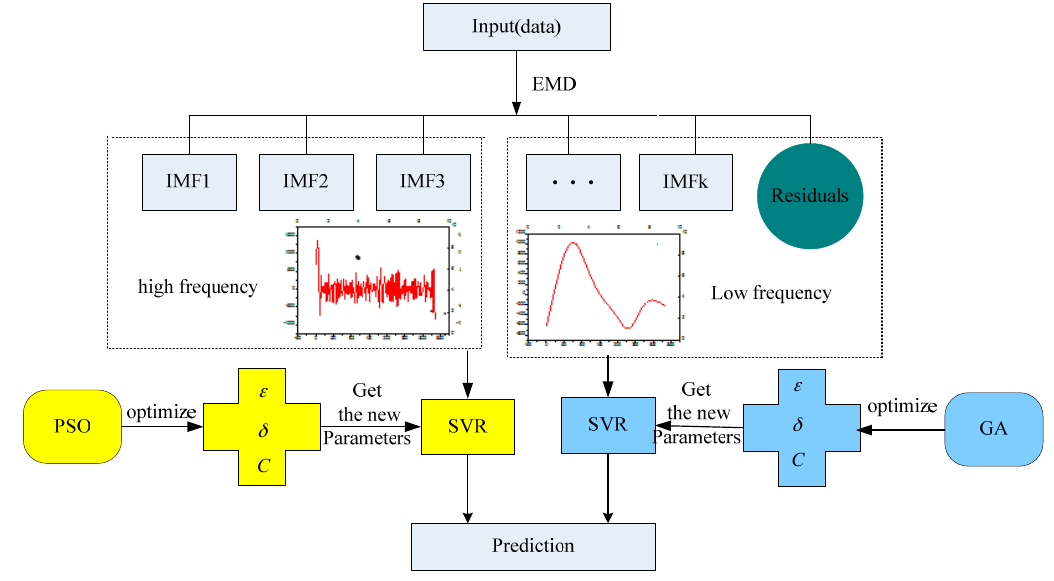
Figure 3. The total flowchart of the proposed empirical mode decomposition (EMD)-PSO-GA-SVR model.